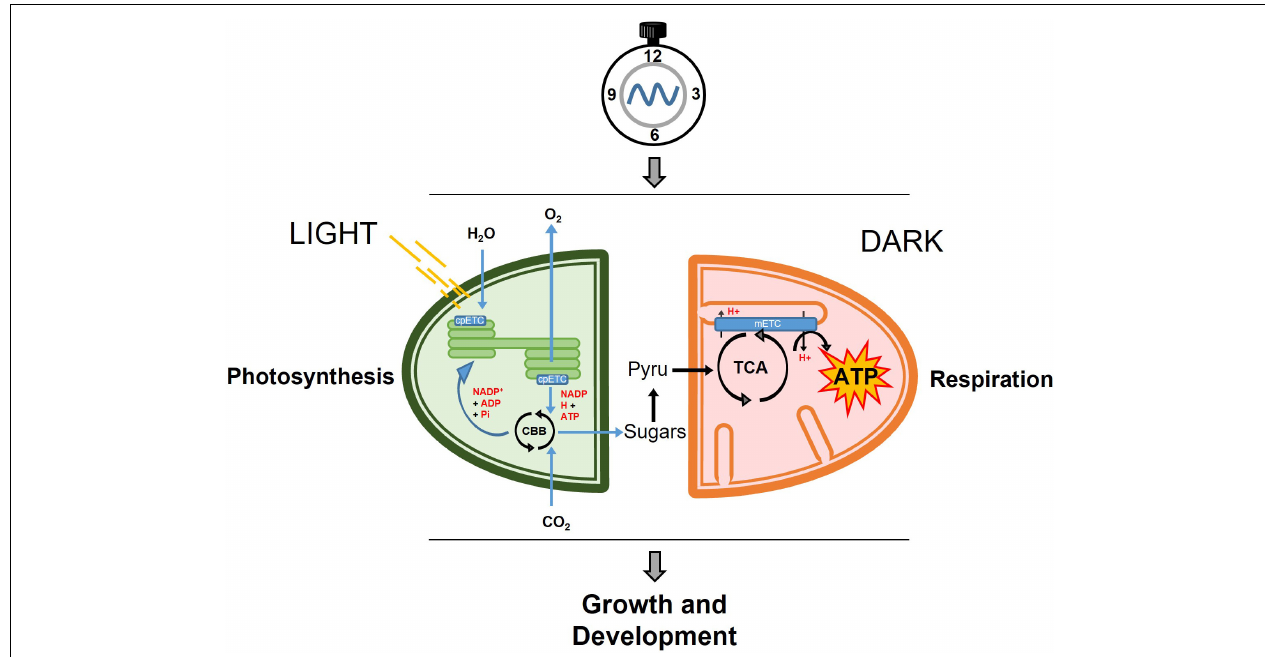
FIGURE 1 | Simplified view of the temporal partitioning by the circadian clock of central metabolism in photosynthetic cells. During the day, carbon is fixed through the photosynthetic reactions in the chloroplast and exported in the form of soluble sugars to the cytosol where it will be converted into pyruvate. In the dark, pyruvate feeds the mitochondrial respiration through the TCA cycle, and subsequently the mitochondrial mETC to generate ATP, which will be used for growth and development. cpETC, chloroplastic electron transport chain; CBB, Calvin-Benson-Bassham cycle; Pyru, Pyruvate; TCA, Tricarboxylic Acid Cycle; mETC, mitochondrial electron transport chain; ATP, adenosine